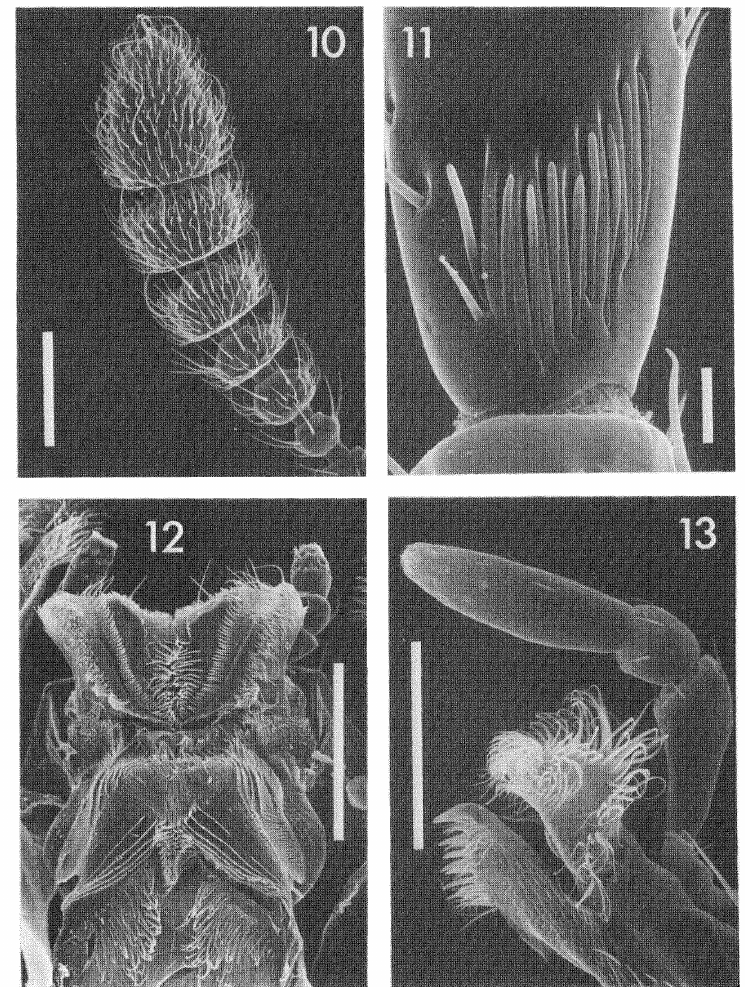
Figs. 10-13. Glypholoma pustuliferum. 10. Apical antennal segments. 11. Base of fourth maxillary palpal segment, external view. 12. Hypopharynx and labium, dorsal view. 13. Left maxilla, ventral view. Scale lines: fig. 11 0.01 mm; others 0.1